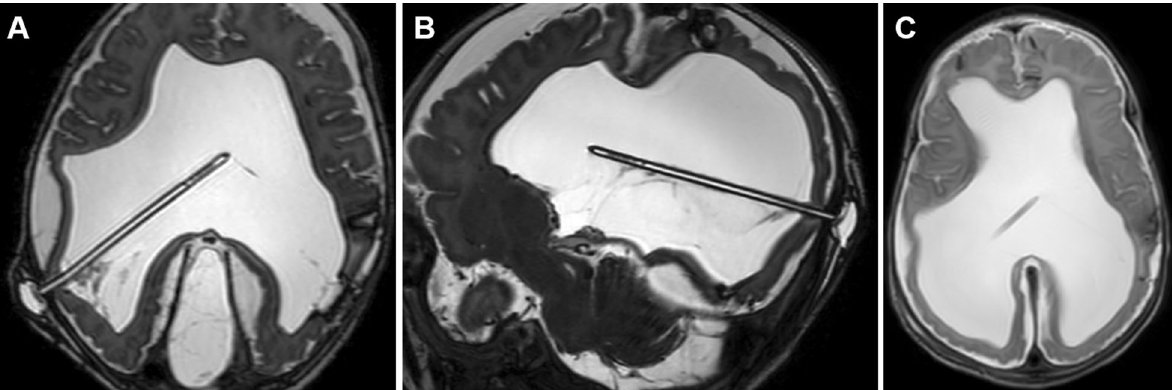
Fig. 3 A 2‑month‑old boy presented with fever and poor feeding. A , B Reconstructed 3D‑DRIVE in axial and sagittal oblique planes, respectively, shows multiple fine ventricular septae surrounding proximal catheter that shows intraluminal faint low signal, which may represent intraluminal extension of these septae along with luminal debris. C Axial T2‑WI for the same patient does not show any intraventricular septae or shunt catheter lumen